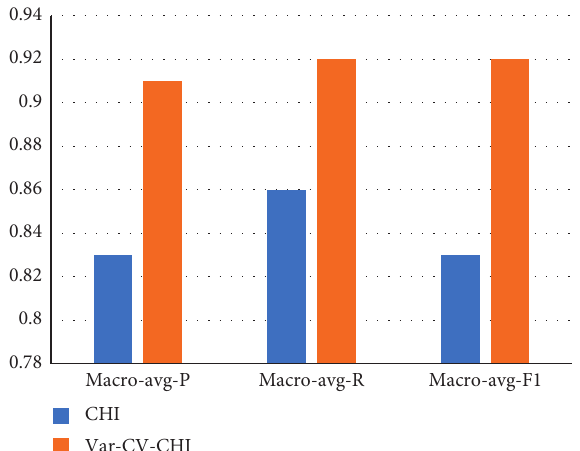
Figure 6: Comparison of macroresults between CHI and Var-CV- CHI on the unbalanced Chinese corpus (Na ¨ ıve